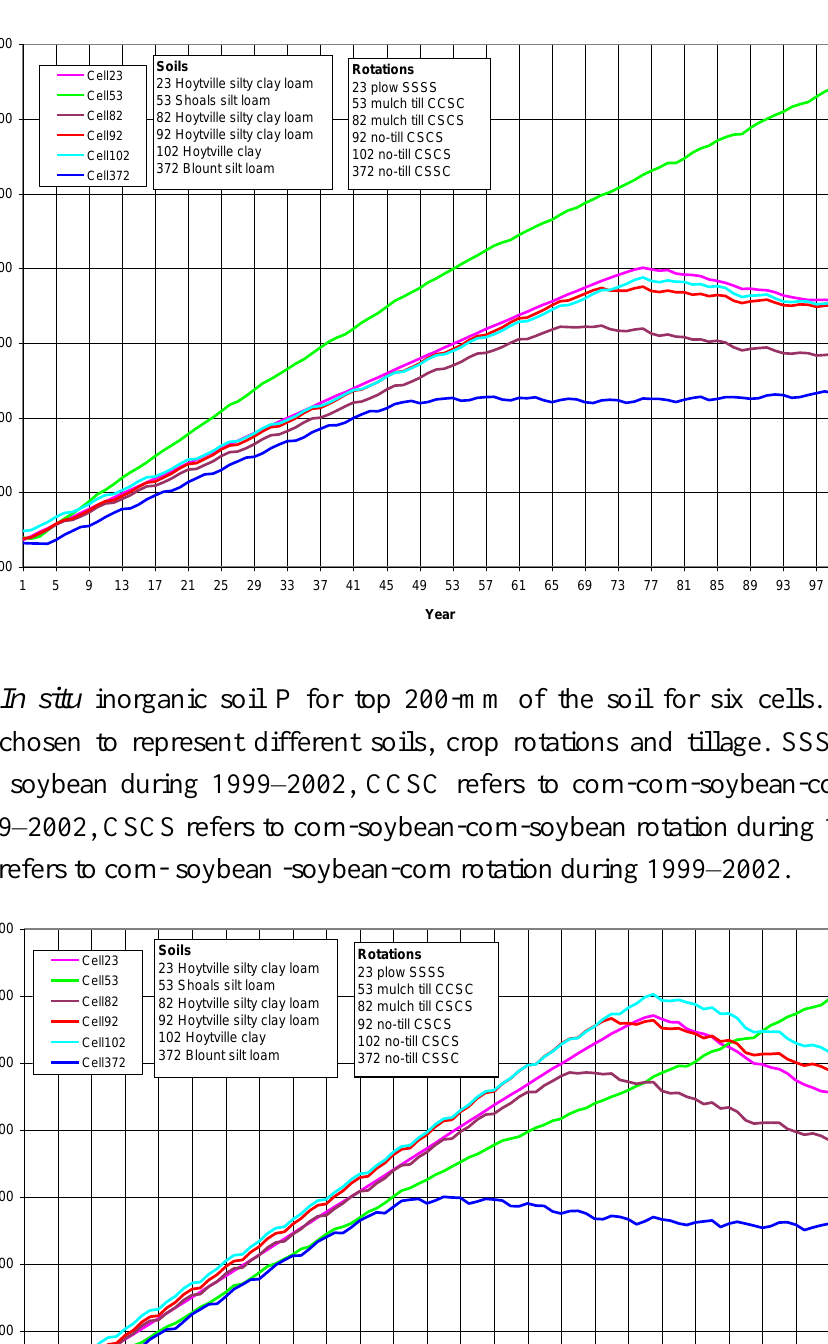
Figure 6 . In situ total soil P for top 200-mm of the soil for six cells. Cells were arbitrarily chosen to represent different soils, crop rotations and tillage. SSSS refers to continuous soybean during 1999–2002, CCSC refers to corn-corn-soybean-corn rotation during 1999–2002, CSCS refers to corn-soybean-corn-soybean rotation during 1999–2002, and CSSC refers to corn- soybean -soybean-corn rotation during 1999–2002.